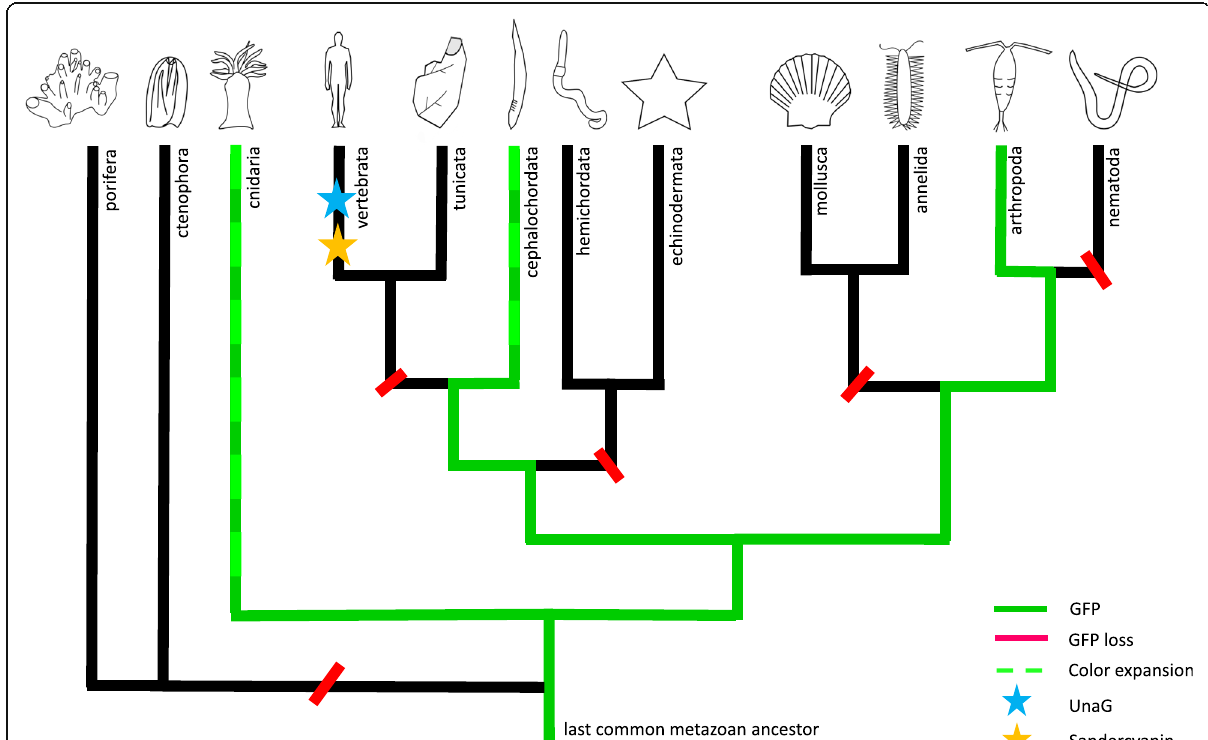
Fig. 2 Distribution of fluorescent proteins in metazoan. Canonical GFPs have been found in cnidarian, arthropods and cephalochordates, supporting the hypothesis of a common metazoan ancestral origin. Color expansion is present in cnidarians and has been recently showed in cephalochordates as well. Furthermore, two other FPs, not related to GFP, have been characterized in vertebrates: UnaG and